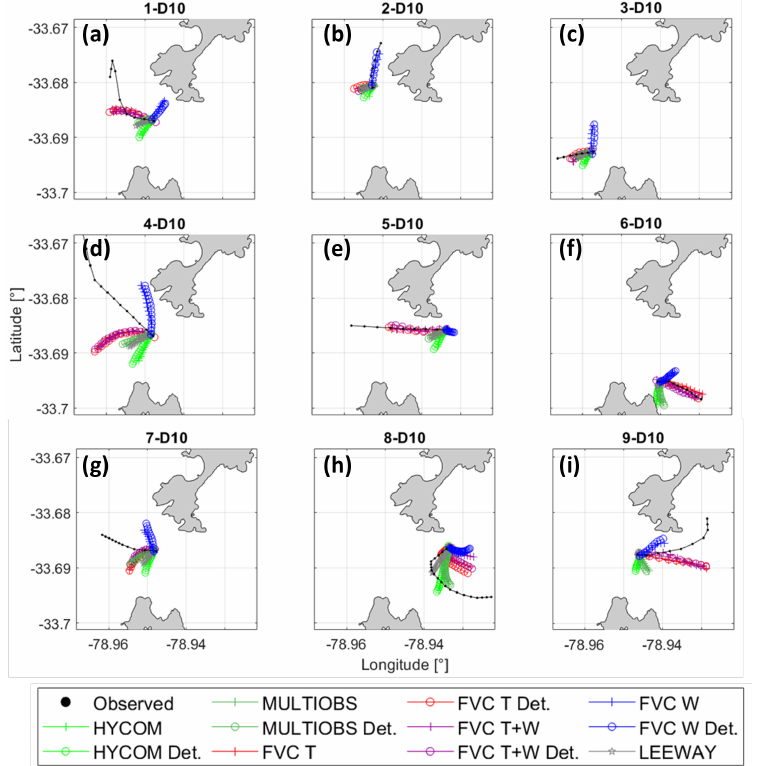
Figure 10. Geographic comparison between measured and modeled drifters with best NCLS mod for 10 September 2011. ( a – i ) Drifter deployments 1–9, respectively, as indicated in Figure 9a. Panel titles indicate drifter deployment number (X-D10, where X is drifter number). FVC = FVCOM; T = Tide; W = Wind; Det. = deterministic (drag force) method.